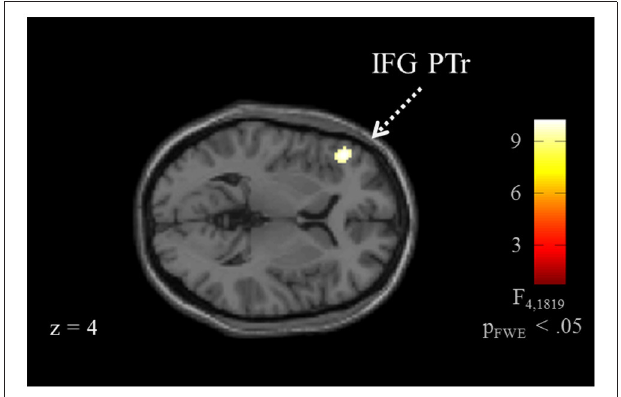
FIGURE 4 | ISC for the conventionality task. The analysis for task effects, i.e., without the intercept, revealed a confined pattern at the left inferior frontal gyrus (IFG; p FWE < 0.05) for the conventionality task (CON) over the control tasks and across task comparisons. For a visualization with the more liberal threshold uncorrected p < 0.001, see Figure